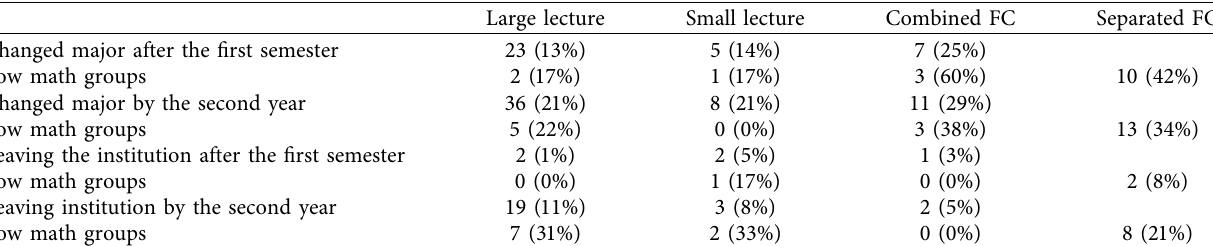
Table 4: Transfers out of the major and